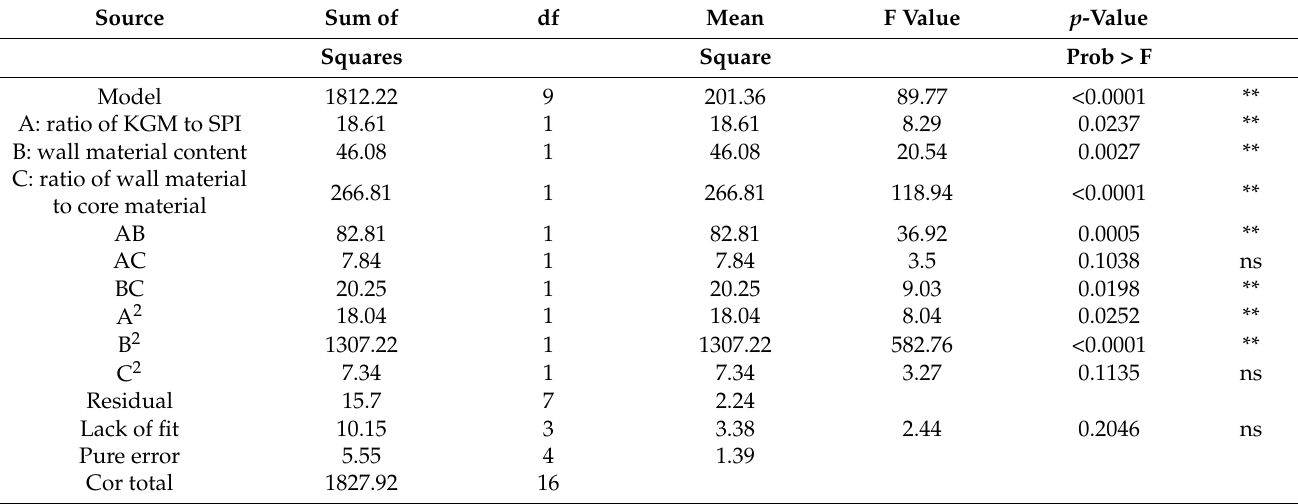
Table 2. ANOVA for the response surface Box–Behnken quadratic